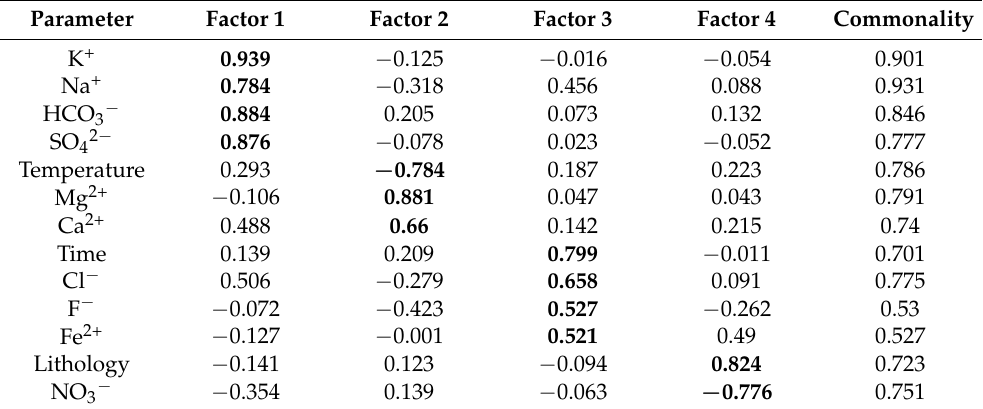
Table 3. Rotated factor loading matrix.